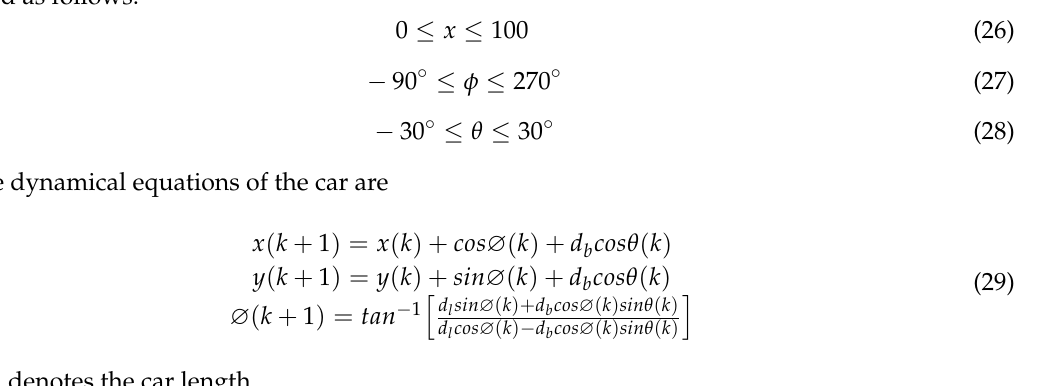
Figure 29. The simulated car and desired dock.